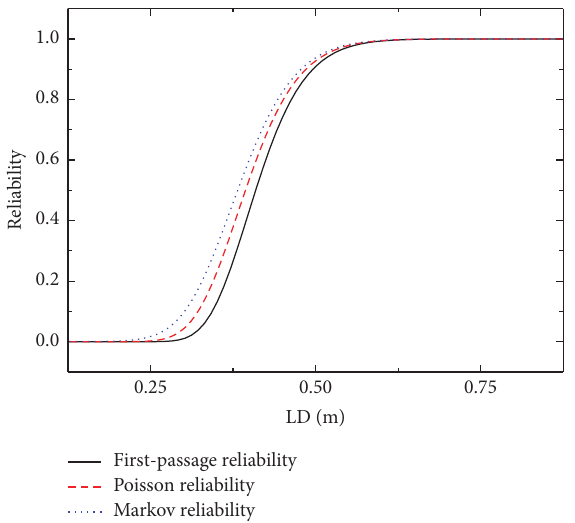
Figure 5: Reliability of lateral displacement.